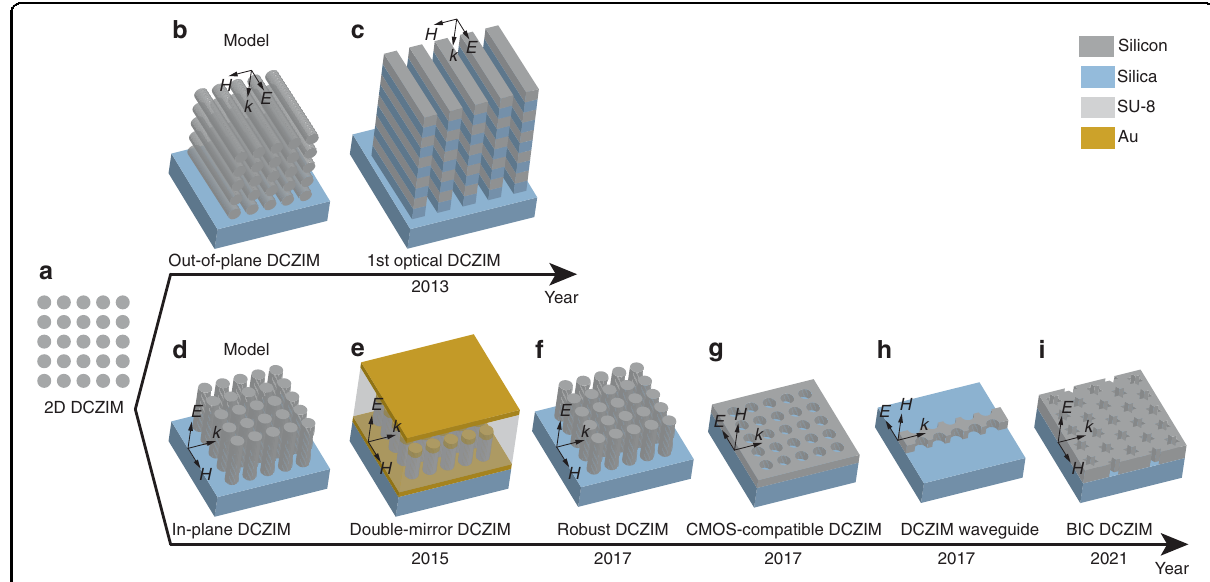
Fig. 4 Development of optical DCZIMs. a Original theoretical design of DCZIM consists of a square array of 2D silicon pillars 21 . b Out-of-plane con fi guration of DCZIM with the plane of periodicity perpendicular to substrate. c First optical DCZIM realized in the out-of-plane con fi guration 56 . d In-plane con fi guration of DCZIM with the plane of periodicity parallel to substrate. e In-plane DCZIM consists of a square array of silicon pillars embedded within a SU-8 matrix and clad by gold mirrors 57 . f In-plane DCZIM shows robustness against the fabrication imperfection in the radii of pillars 79 . g In-plane CMOS-compatible DCZIM consists of a square array of air holes in a 220-nm silicon on insulator 51 . h In-plane 1D DCZIM waveguide 31 . i In-plane DCZIM achieves ultra-low propagation loss via bound states in the continuum (BIC)